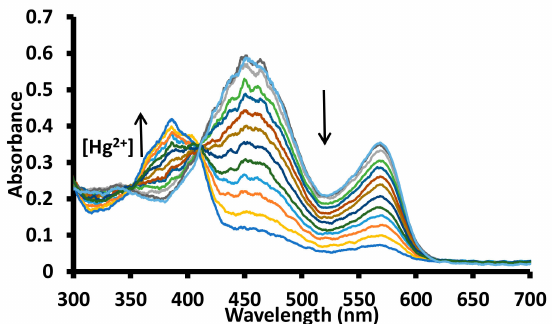
Figure 9. Change in the absorption spectra of a solution of receptor 1 in water (pH = 7.6, 1.0 mM HEPES) upon incremental addition of acetate salts of mercuric ions. The up arrow indicates an increase in absorption band intensity, while a down arrow indicates a decrease in absorption band intensity with an increase in mercuric ion concentration; [ 1 ] = 20 µ M; [Hg 2 + ] = 0–13.63 µ M.